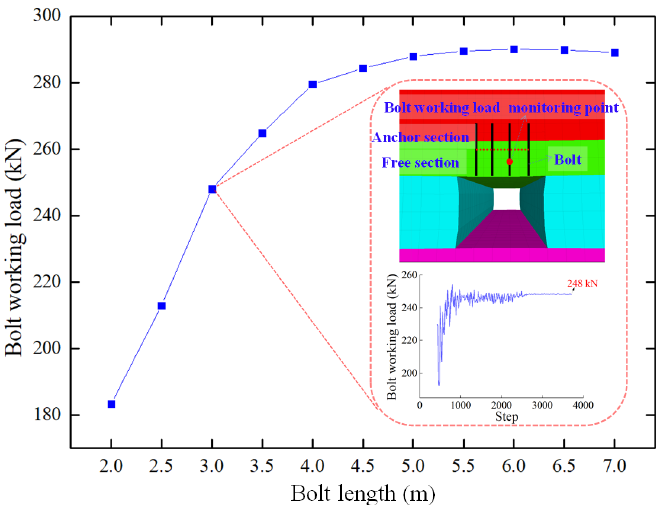
Figure 9. Distribution of the working load of the bolt with different anchorage thicknesses of roofs.